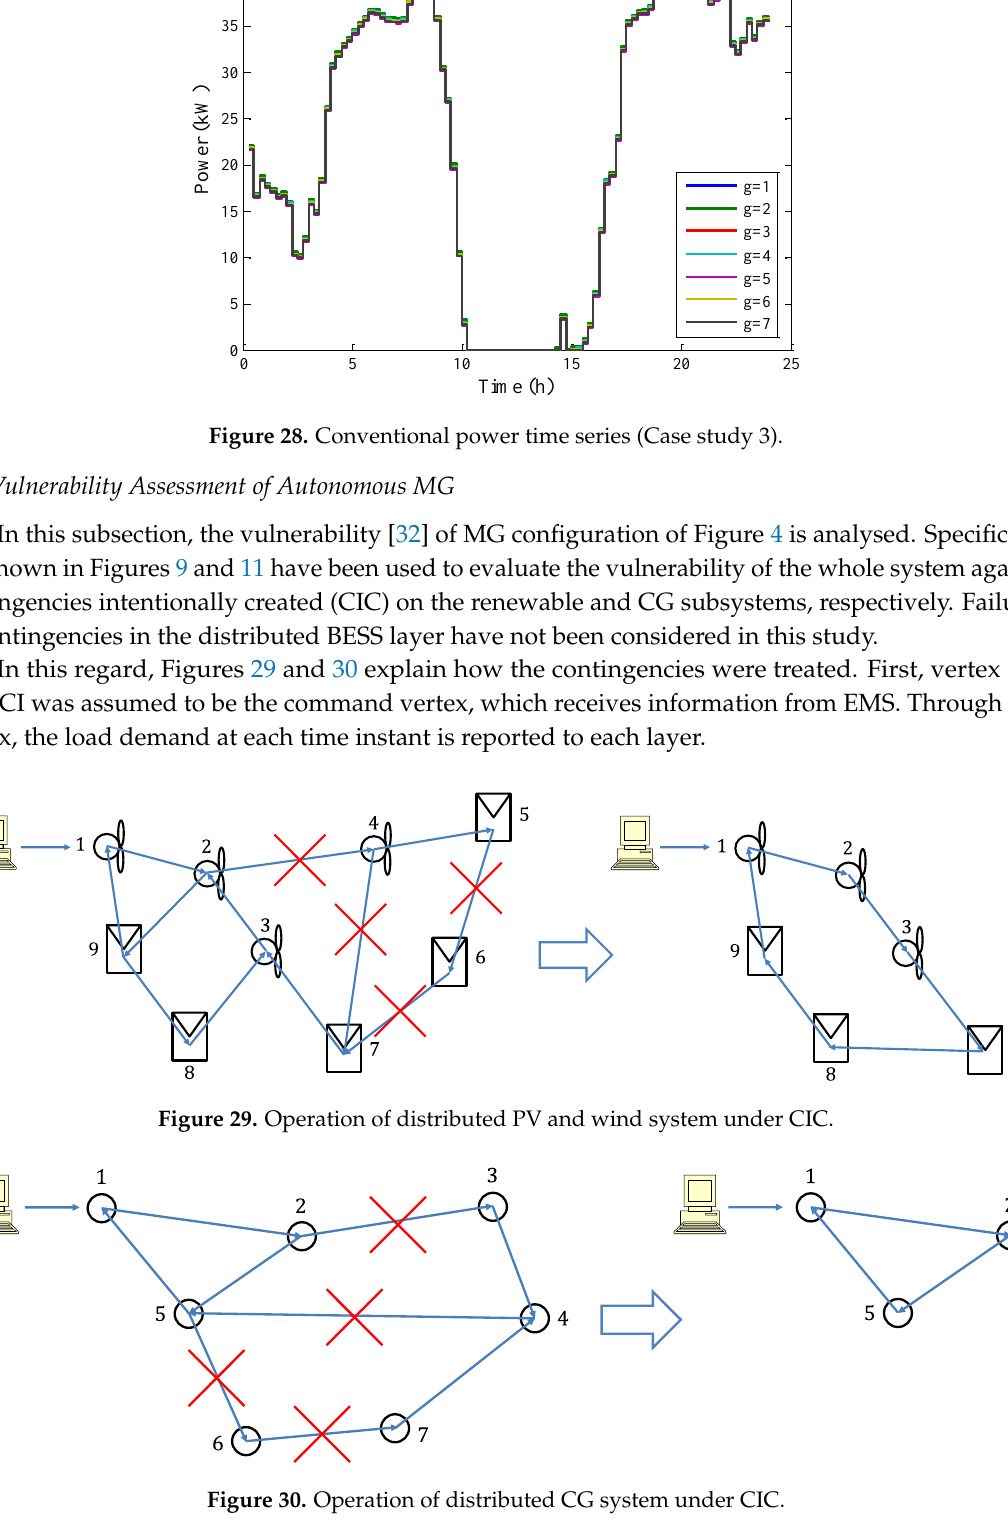
Figure 28. Conventional power time series (Case study 3).